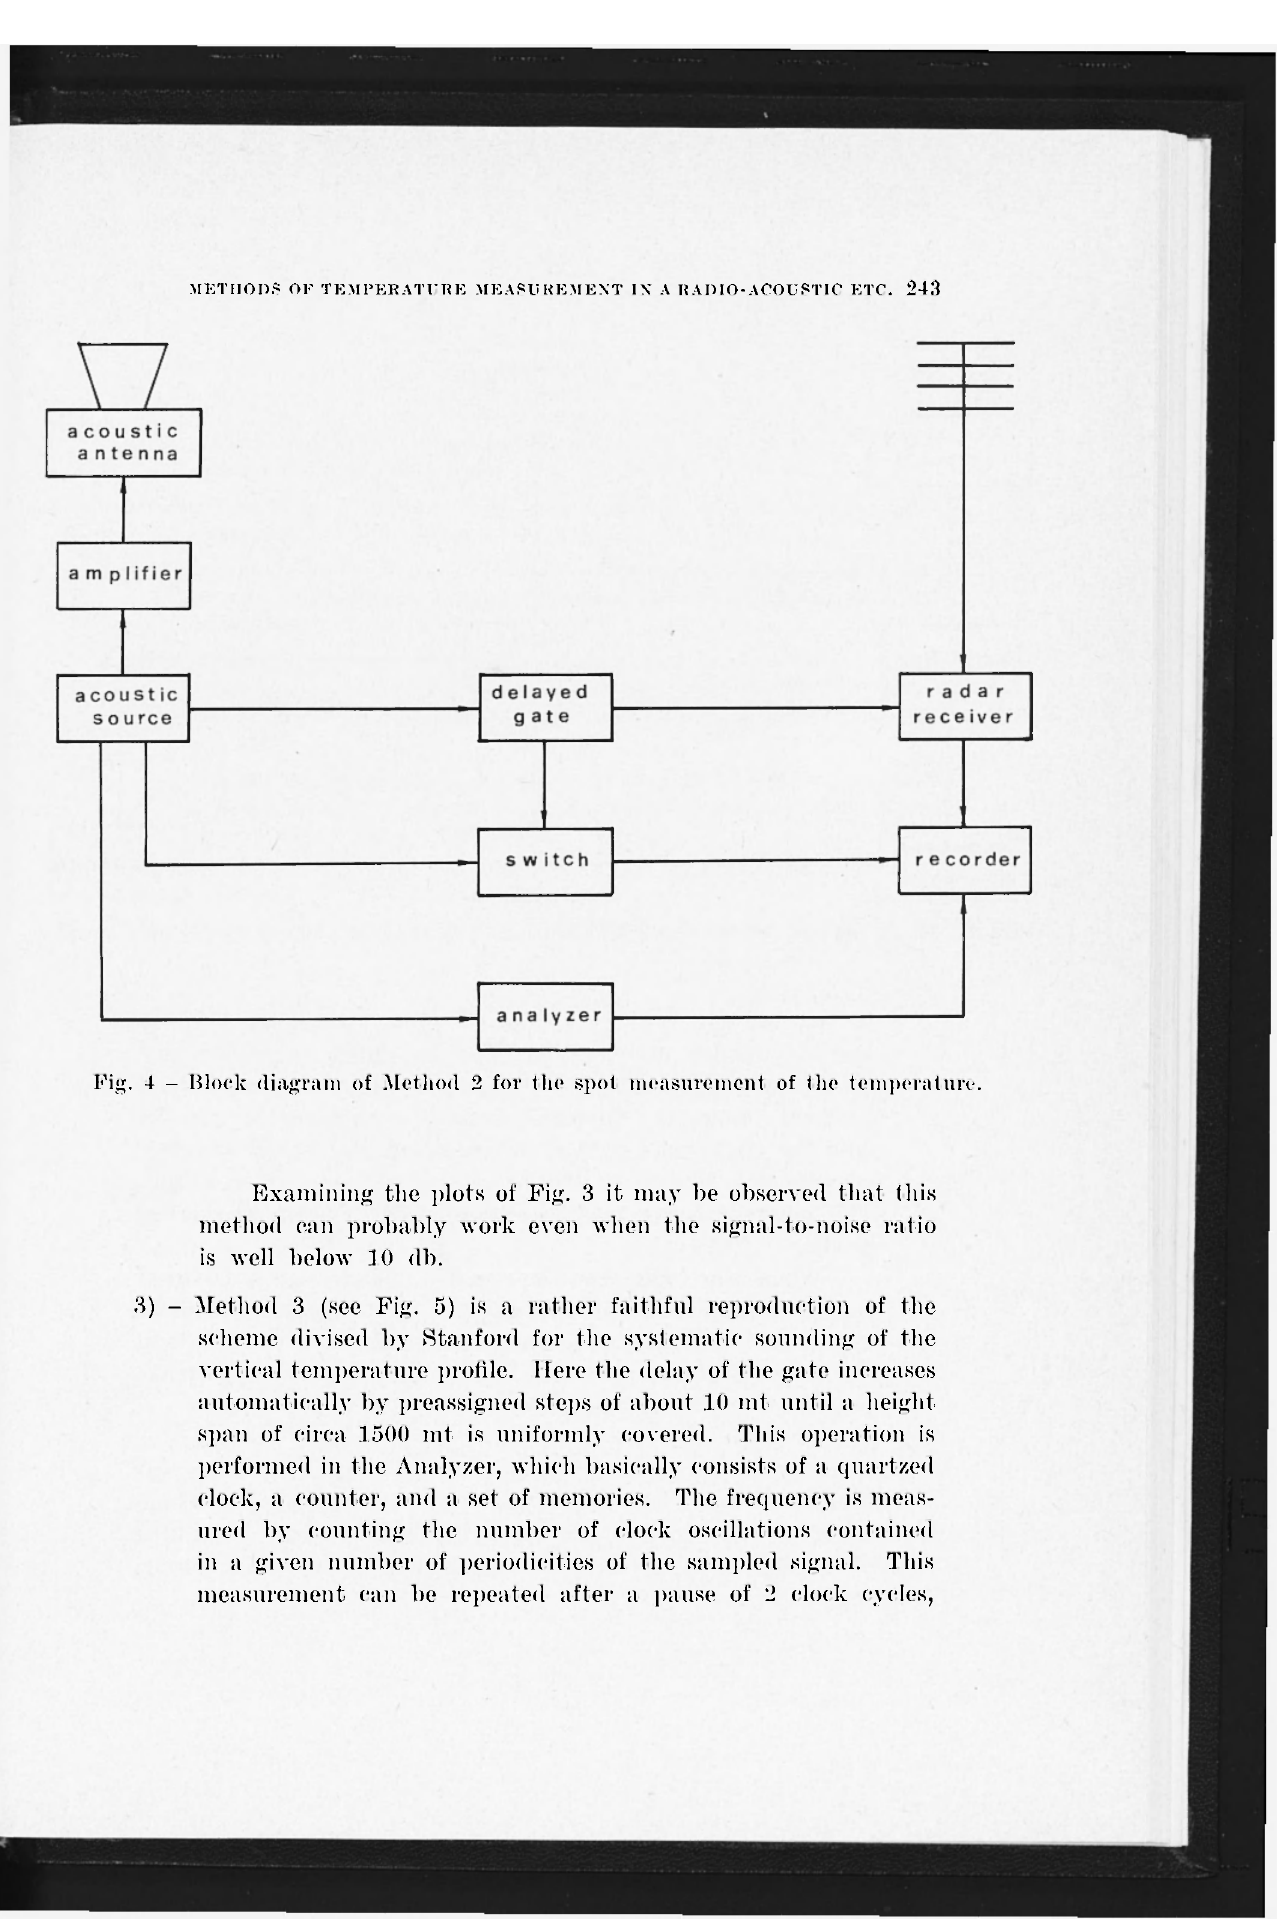
Examining the plots of Fig. 3 it may be observed that this method can probably work even when the signal-to-noise ratio is well below 10 db. 3) - Method 3 (see Fig. 5) is a rather faithful reproduction of the scheme divised by Stanford for the systematic sounding of the vertical temperature profile. Here the delay of the gate increases automatically by preassigned steps of about 10 mt until a height span of circa 1500 mt is uniformly covered. This operation is performed in the Analyzer, which basically consists of a quartzed clock, a counter, and a set of memories. The frequency is meas- ured by counting the number of clock oscillations contained in a given number of periodicities of the sampled signal. This measurement can be repeated after a pause of 2 clock